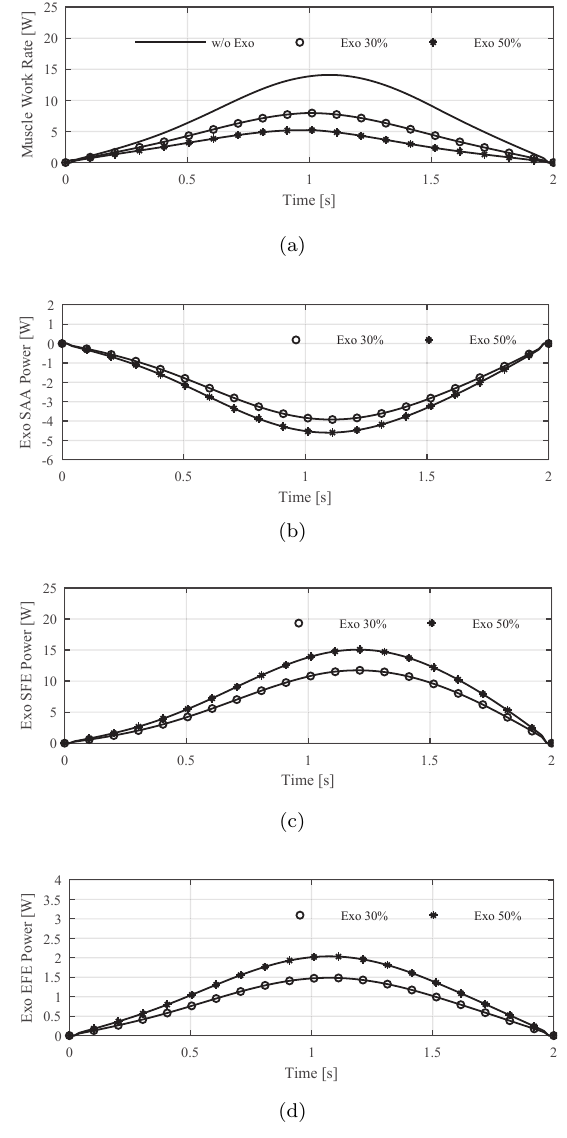
Figure 14: Energy flow in between the human and exoskeleton during the overhead reach de- picted by: (a) the total muscle work rate, (b) the power consumption of the shoulder abb/abd, (c) the power consumption of the shoulder flex/ext, (d) the power consump- tion of the elbow flex/ext